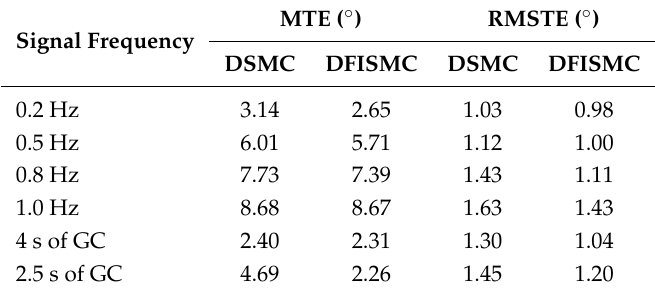
Figure 6. Maximum tracking error (MTE) and root mean square tracking error (RMSTE) of the proposed controller and conventional DSMC controller with 0.2 Hz, 0.5 Hz, 0.8 Hz, and 1.0 Hz of the desired signal frequency in case of no load. Table 4. Maximum tracking error (MTE) and root mean square tracking error (RMSTE) of the proposed control method and conventional DSMC control method in case of no